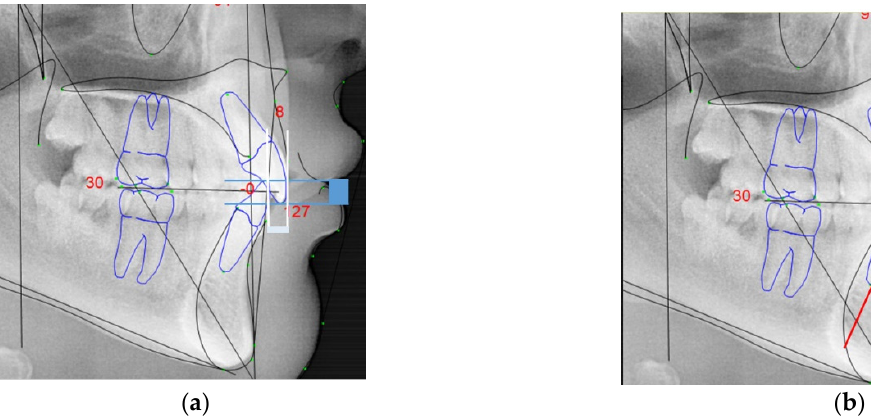
Figure 3. Linear and angular references for cephalometric analysis studied: ( a ) overbite (blue) and overjet (white); ( b ) lower incisor protrusion (red).